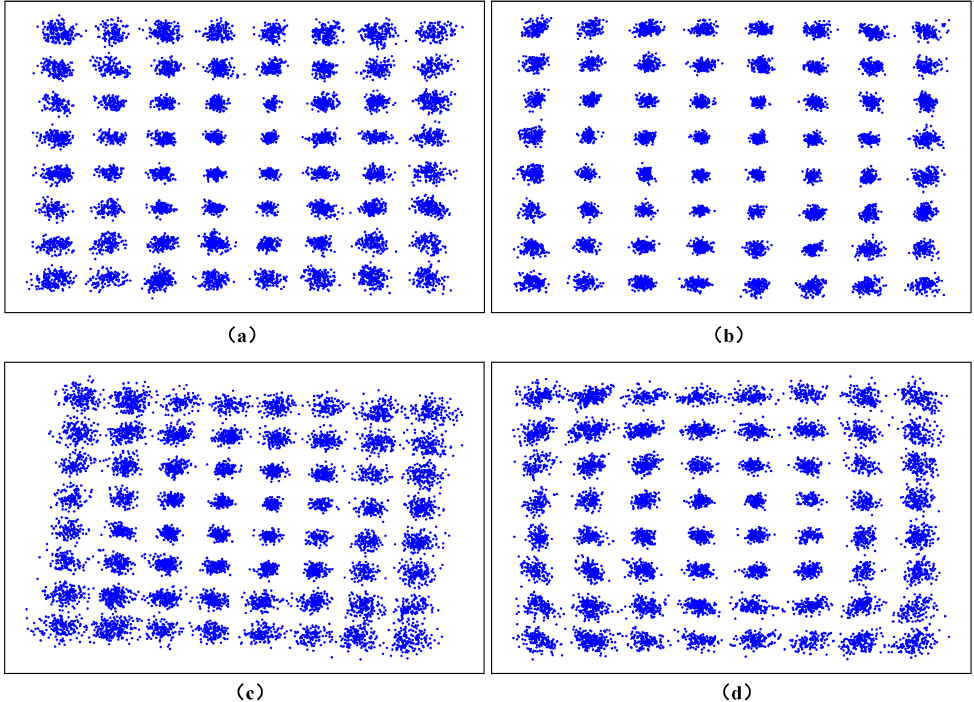
Figure 10. Constellation diagram of received signal on the 10th subcarrier recovered by ( a ) LS and ( b ) RC; constellation diagram of received signal on the 31th subcarrier recovered by ( c ) LS and ( d )